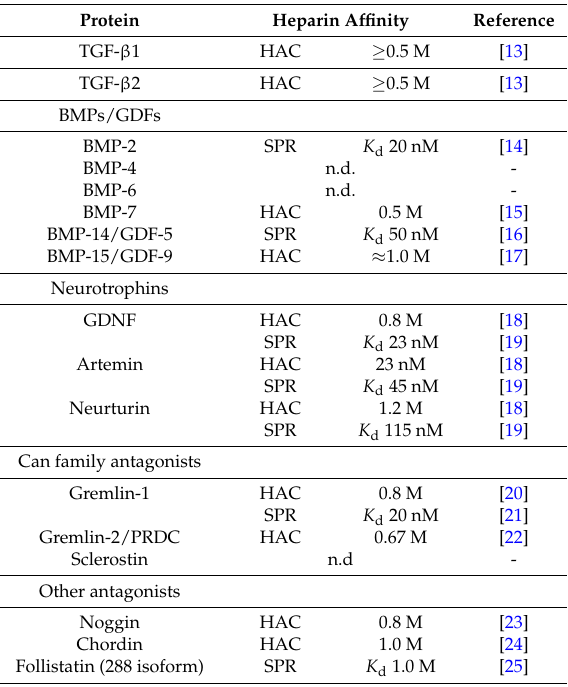
Table 1. Heparin-binding affinity estimates of TGF- β superfamily cytokines.